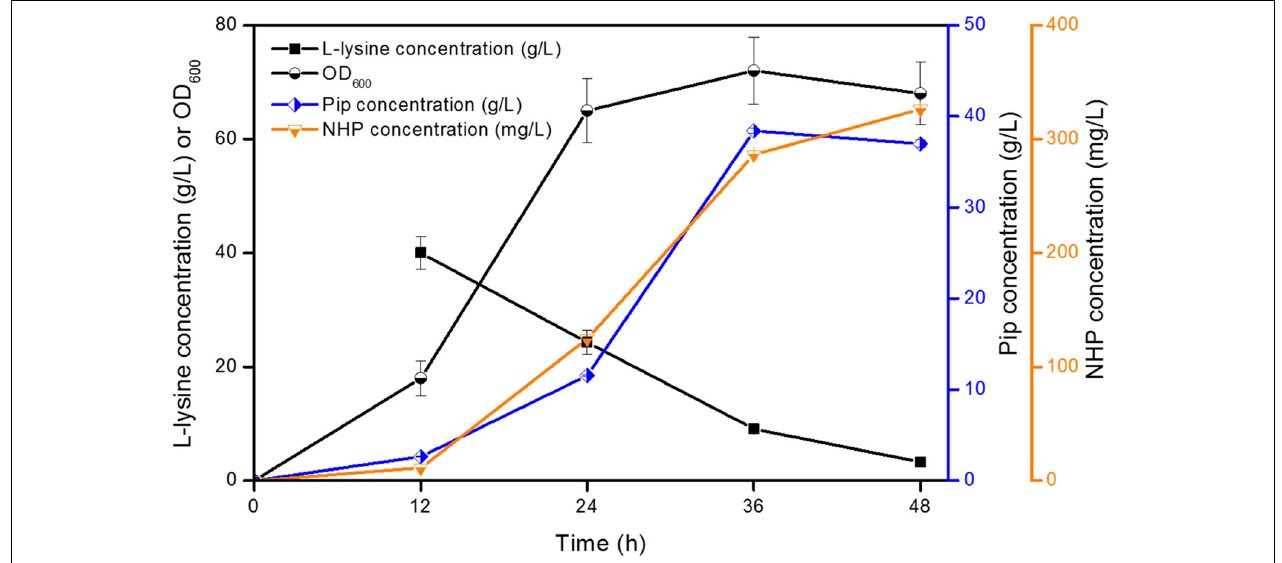
FIGURE 3 | Time profiles of NHP production were investigated in E. coli ML08 in a 5-L fermenter. The experiments were conducted at 40 g/L of L-lysine. Each experiment was done at least in triplicate. Error bars indicate standard errors of the